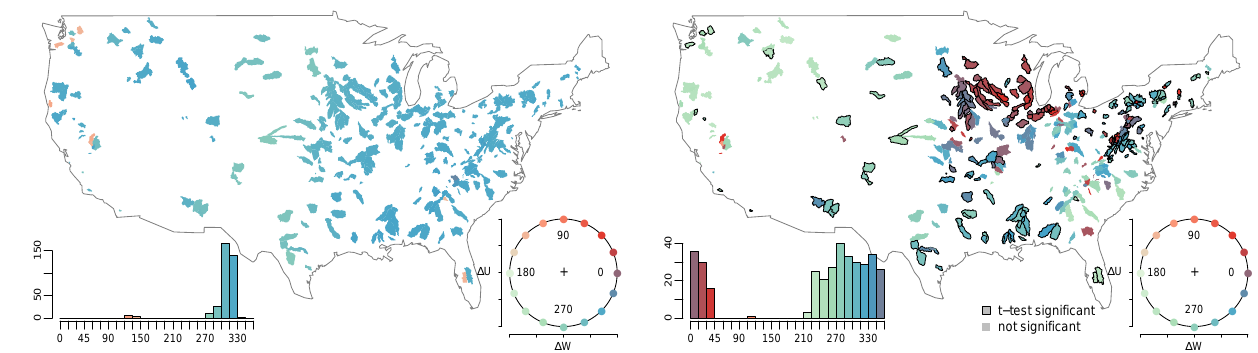
Fig. 9. Mapping of the change direction ω in UW space. The colour of the polygons indicates the value of ω with the corresponding wheel legend in the bottom right. The left panel shows the theoretical climatic change direction using the Mezentsev function. The right panel shows the observed change direction using Eq. (3). Polygons with a grey border indicate significant (t-test, α = 0.05) changes in any of the observed variables ( P,E p,CRU ,Q